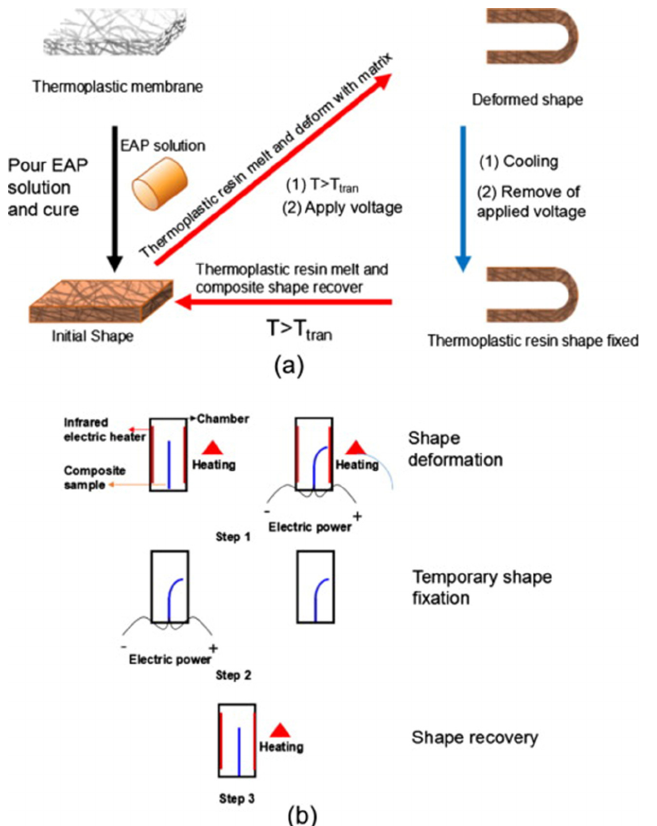
Figure 10. ( a ) Representation of composite fabrication and shape-memory cycles; ( b ) schematic experimental setup for two-way SMPs [80].